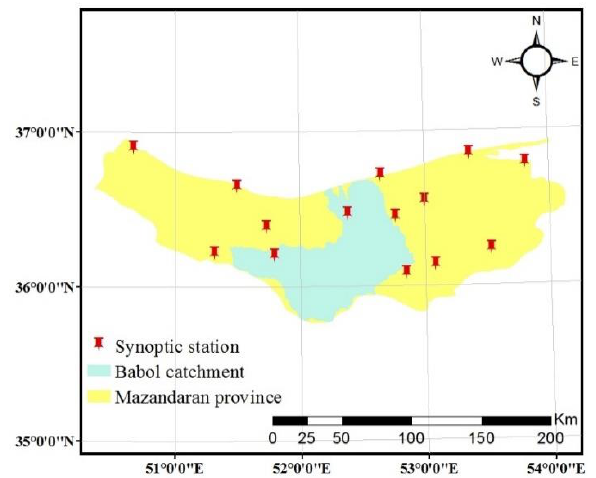
Figure 2. The location of synoptic stations in Mazandaran